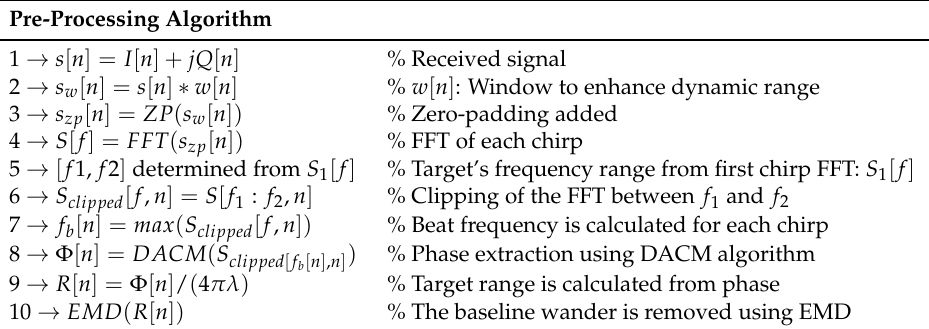
Table 4. Pre-processing algorithm steps.